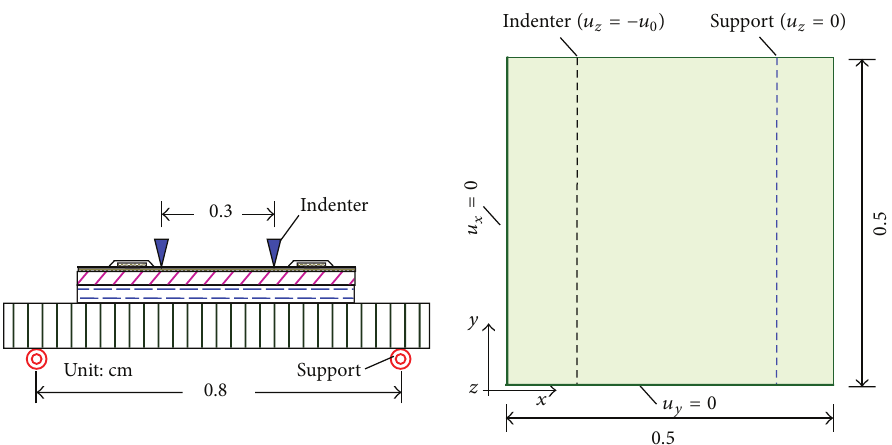
Figure 4: A schematic of four-point bending test and associated boundary condition for FE